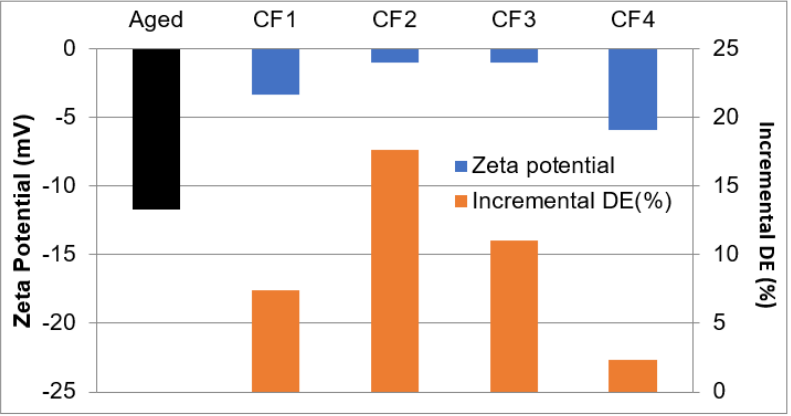
Figure 15. Average zeta potential (pH 3–pH 6) compared to DE (category 1).